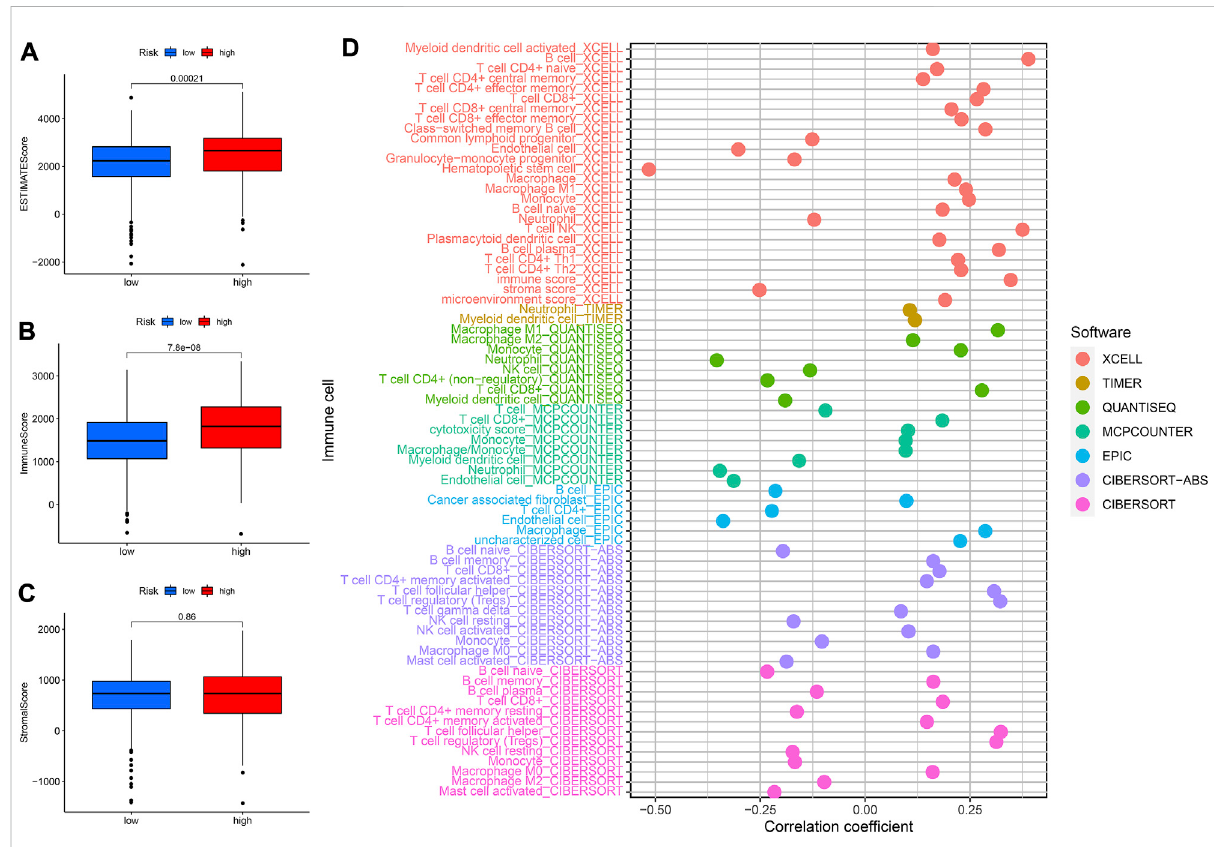
FIGURE 10 Analysisof immune landscape. (A – C) The relationshipbetweenprognosticsignature and TME. (D) The relationship between immune cells and risk score was explored by correlation